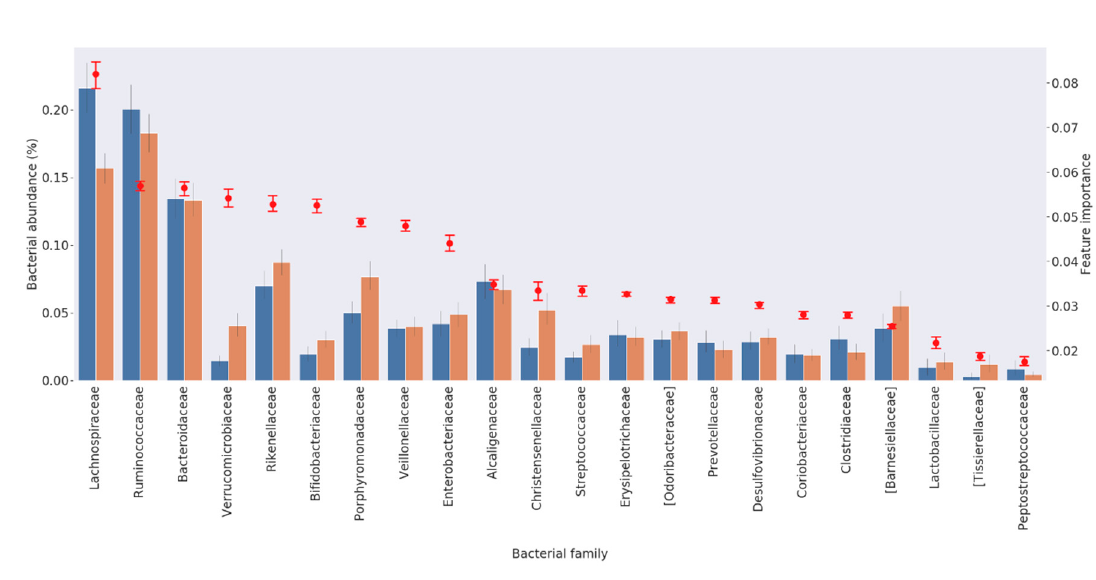
Figure 2. List of the 22 bacterial families required for discriminating between HC and PD patients. For each family, the average percentage of abundance is represented by a bar, orange for HC and blue for PD patients (left scale). The importance of the family in discriminating the status is represented by a red dot (right scale).